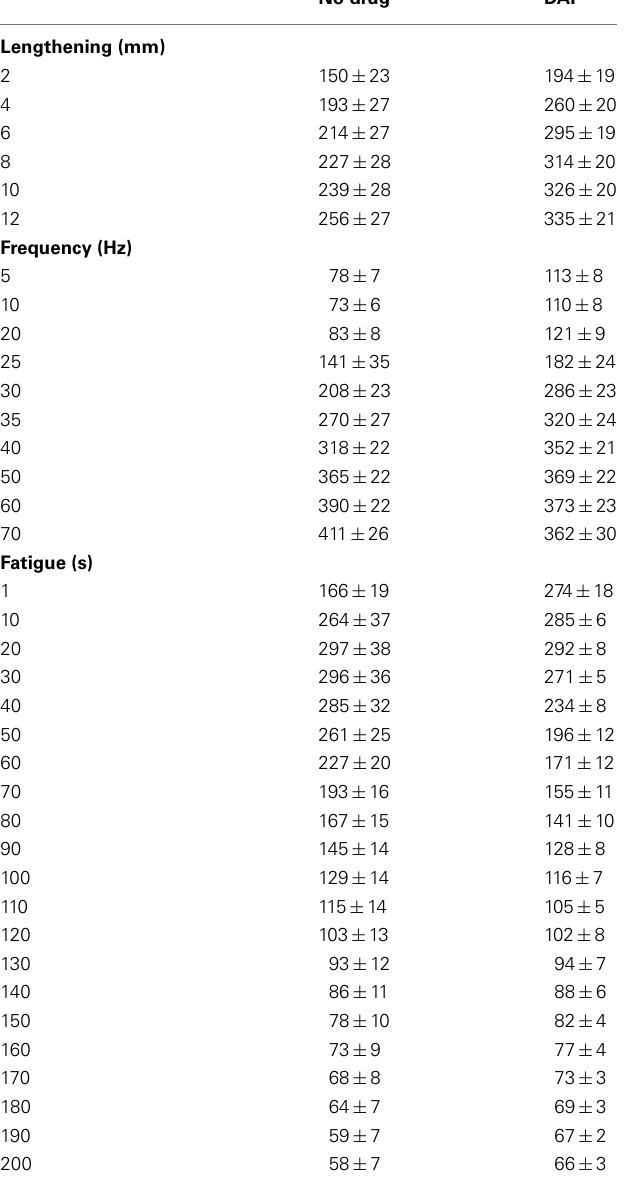
TableA1 | Force (in grams) during 30Hz eccentric contraction at different lengths at a velocity of 2–12mm/s, during eccentric contractions of 1.2mm at constant velocity of 6mm/s at different frequencies and during repeated 1.2mm 30Hz eccentric contractions at constant velocity of 6mm/s with and without